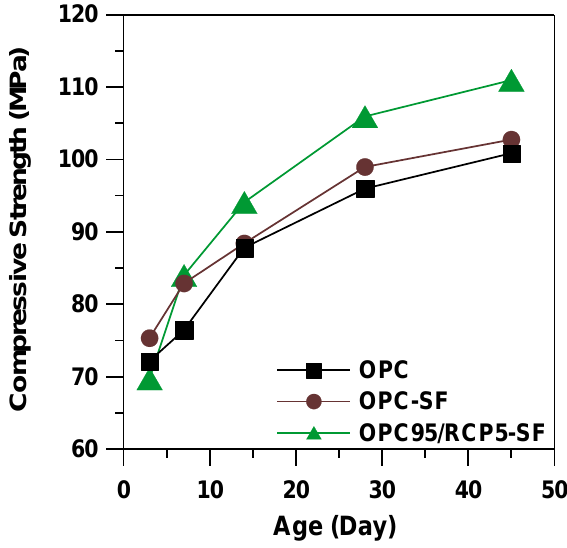
Figure 8. Compressive strength of OPC, OPC–SF, and OPC95/RCP5–SF